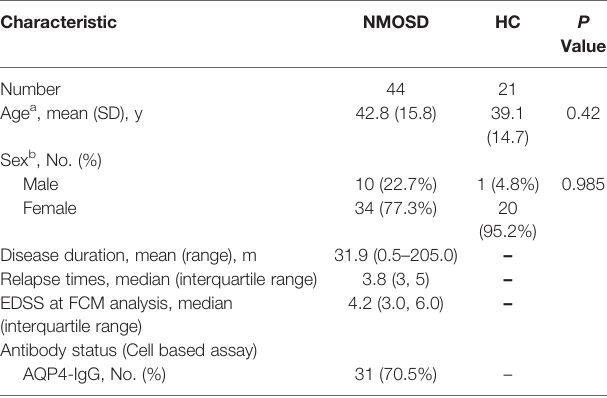
TABLE 1 | Clinical and demographic characteristics of participants who underwent fl ow cytometric